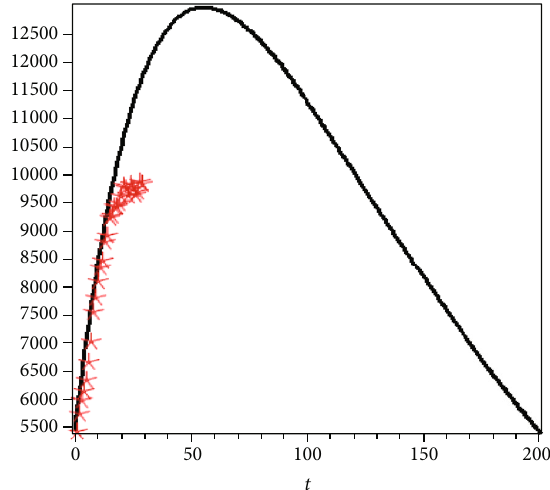
Figure 8: Compared the prediction of model (53 – 55) (black line) with real data of Saudi Arabia (red asterisks) for v = 75000 individual/per day and β 0 = 5 : 10 − 7 , i.e., R 0 ≤ 1 : 64 .